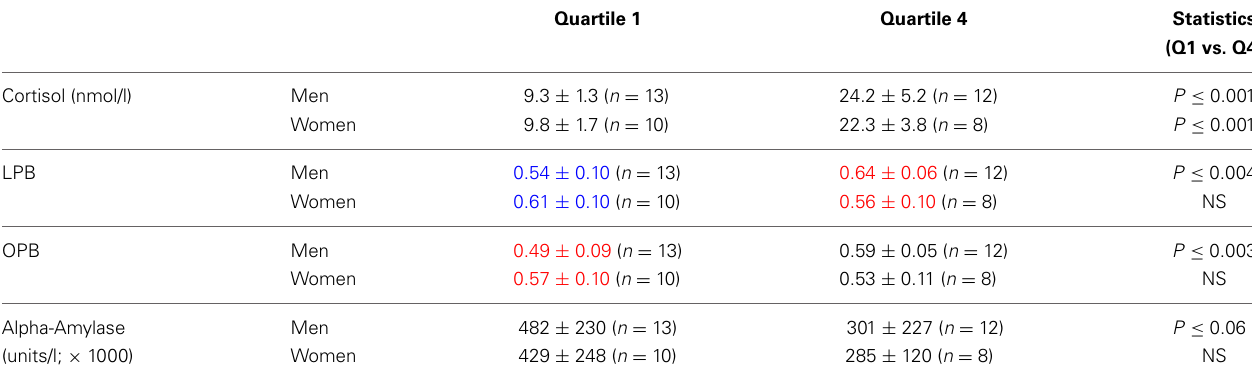
Red: values significantly different between men and women; Blue: values trend between men and women.